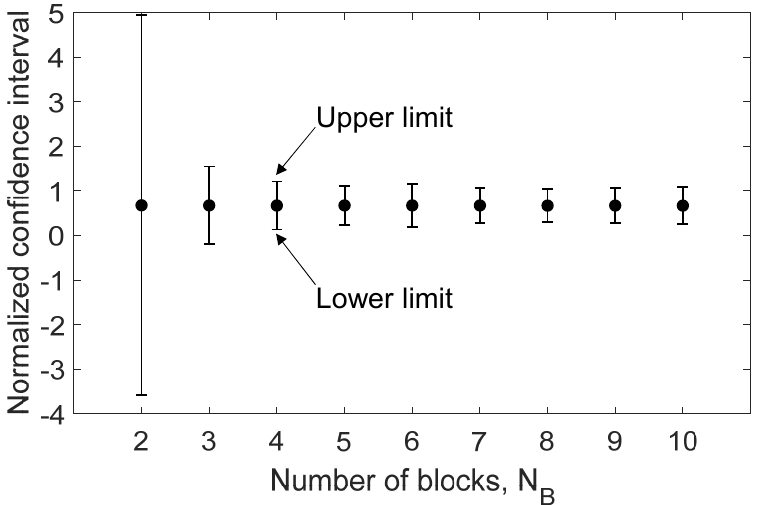
Figure 11. Confidence interval of the damage for the measured time history z ( t ) from the vehicle wheel (CH6 record, outer rim), as a function of the number of blocks, N B